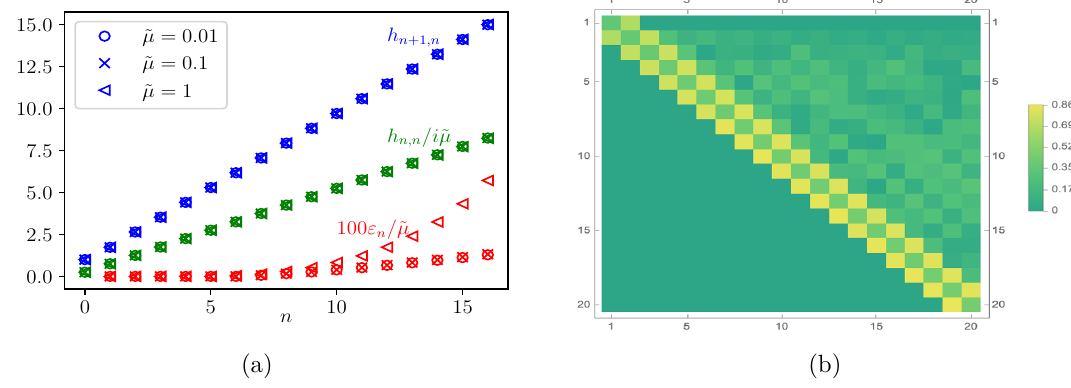
Figure 2 . (a) The diagonal and primary off-diagonal elements in the matrix h m,n resulting from the Arnoldi iteration in the large N , q = 4 dissipative SYK model with ˜ µ = 1 , 0 . 1 , 0 . 01 and J = 1 . The markers indicate the value of ˜ µ . We also plot the quantity ε n defined in (5.6) which measures the distance to the ideal scenario (it is multiplied by 100 for visibility). The diagonal elements and ε n are rescaled by ˜ µ to display the collapse. (b) SYK 4 (i.e., q = 4 ) Lindbladian matrix (single realization) in Krylov (Arnoldi) basis for dissipation µ = 0 . 01 . We fix J = 1 and the system